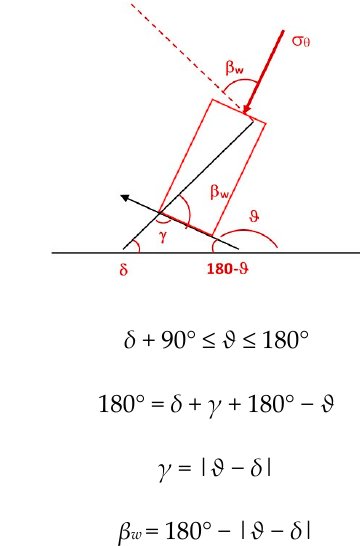
Figure A2. Calculation of the angle β w in the elements around a wellbore in the case of slip failure. The black lines represent the weakness plane. The dotted red lines are the normal to the weakness plane. The tangential stress σ θ is the maximum principal stress.